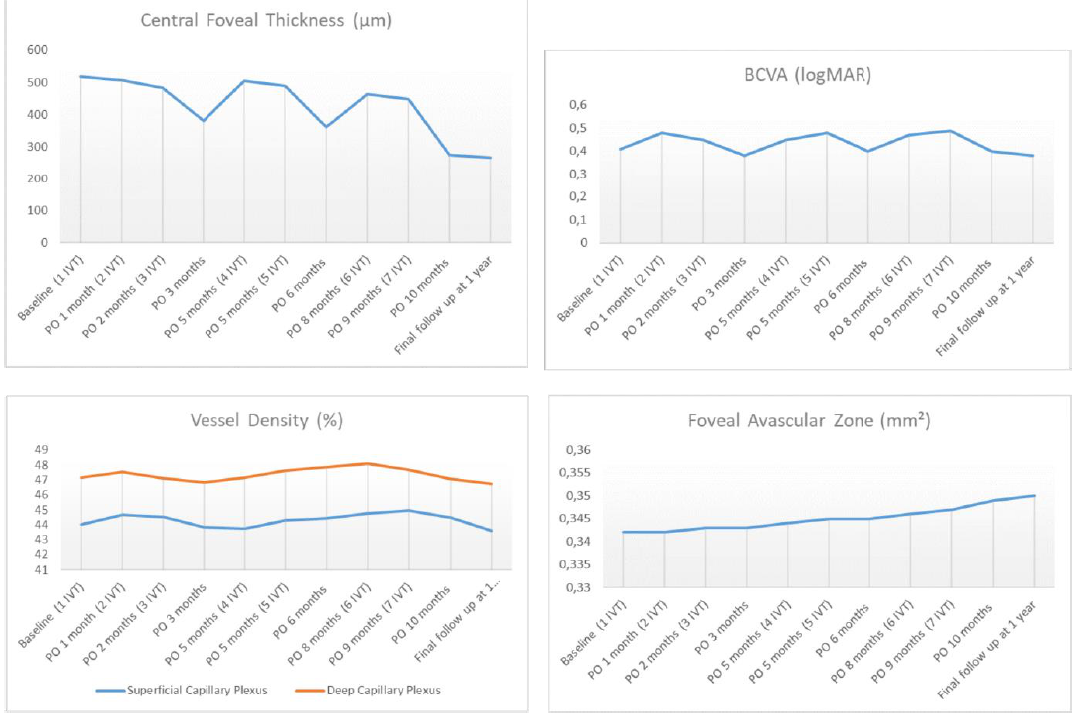
Figure 3. Graphs of measurements of the central foveal thickness (CFT), best corrected visual acuity (BCVA), the retinal vessel density, and the foveal avascular zone in each post operative